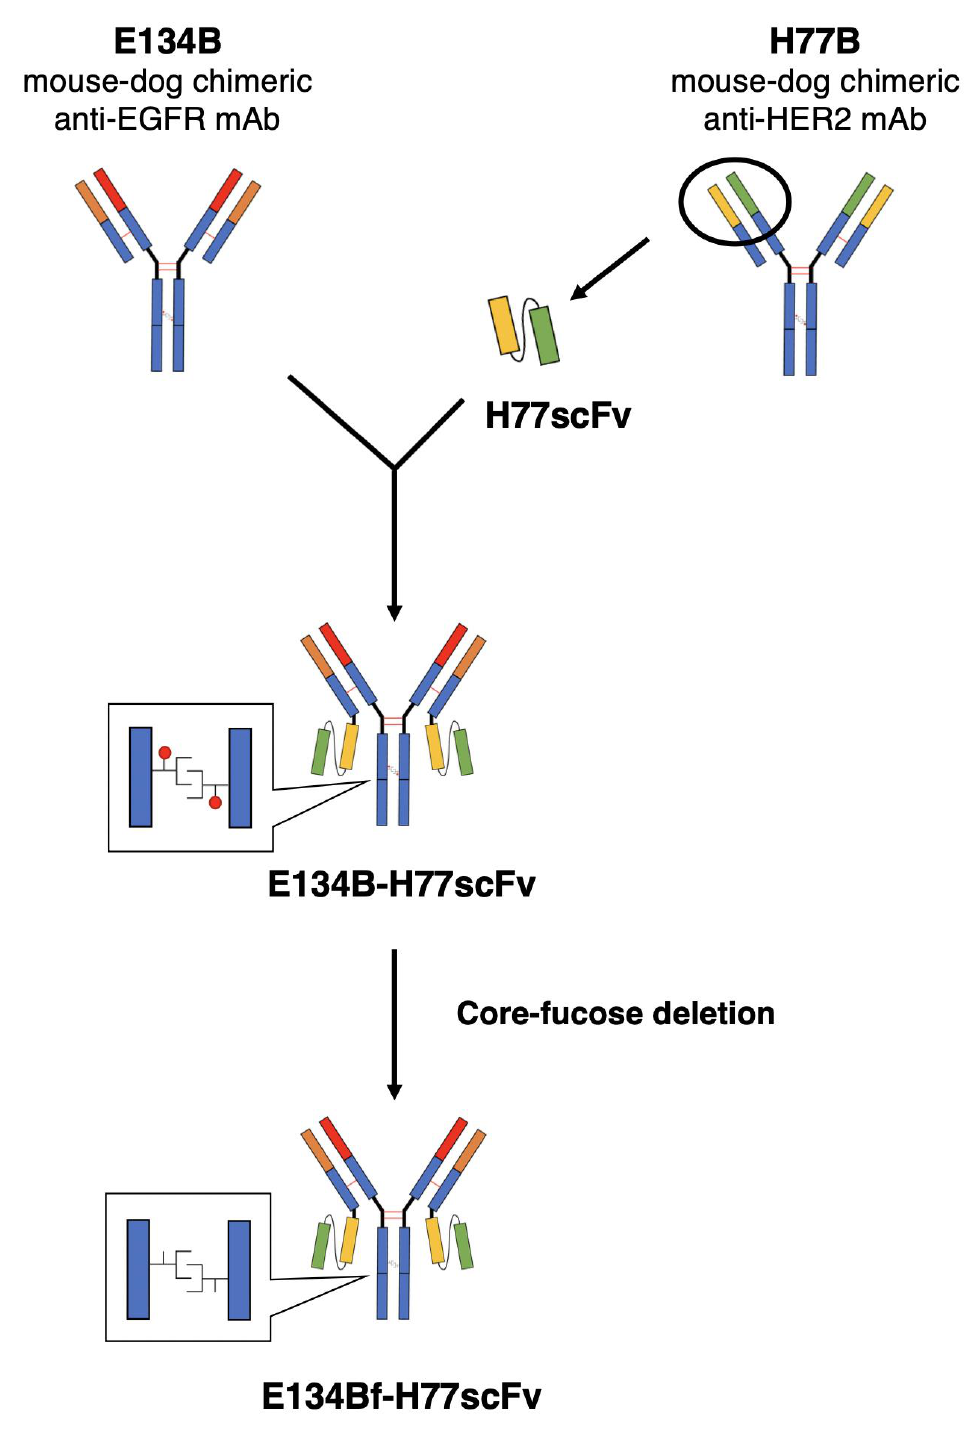
Figure 1. Schematic illustration of the production of bispecific antibody, E134Bf-H77scFv from E134B and H77B.